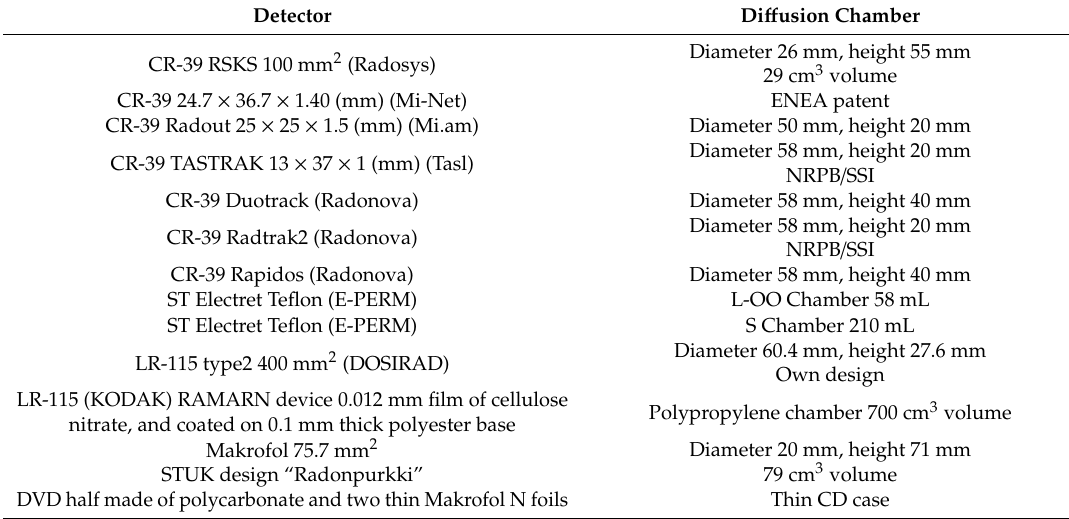
Table 3. Passive detector features provided by the participants.